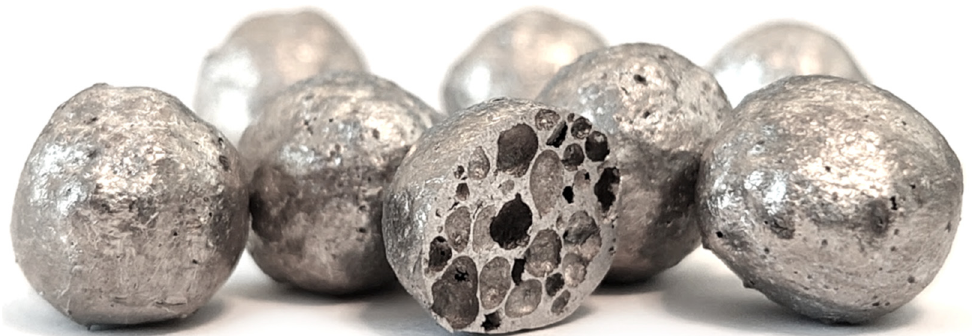
Figure 1. Advanced pore morphology foam elements.